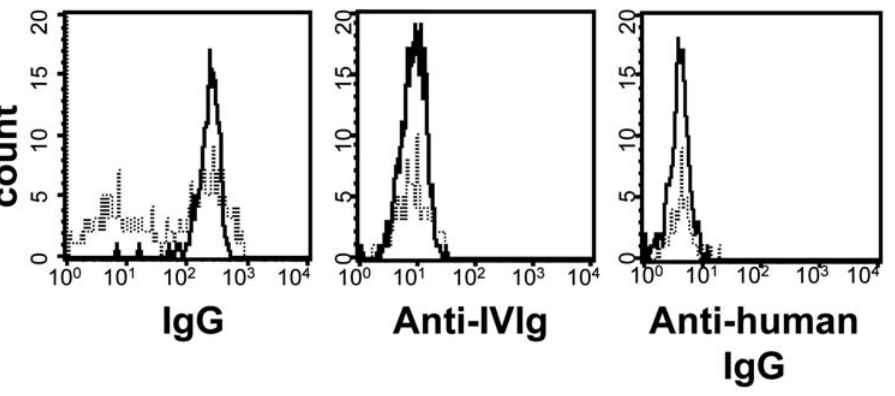
Figure 4. IVIg-mobilized plasma cells are neither IVIg- nor human IgG-specific. CD19 + CD27 high plasma cells were analyzed following intracellular staining with anti-IgG FITC, IVIg FITC and human IgG FITC before (dotted line) and 7 days after IVIg infusion (black line). One